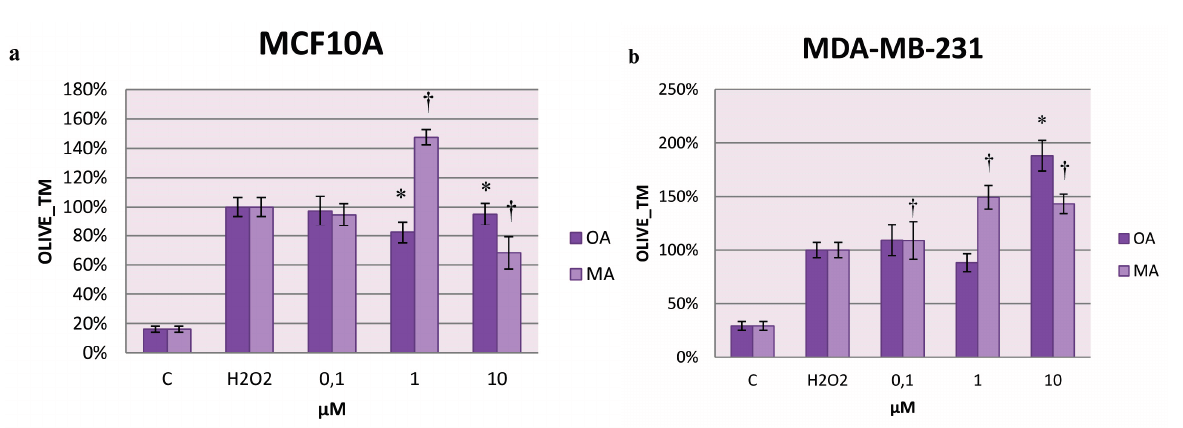
Figure 7. Olive_TM represented in MCF10A cells ( a ) and MDA-MB-231 cells ( b ) treated with OA or MA at 0.1 µM, 1 µM, and 10 µM for 4 h. Values represent the mean ± SEM